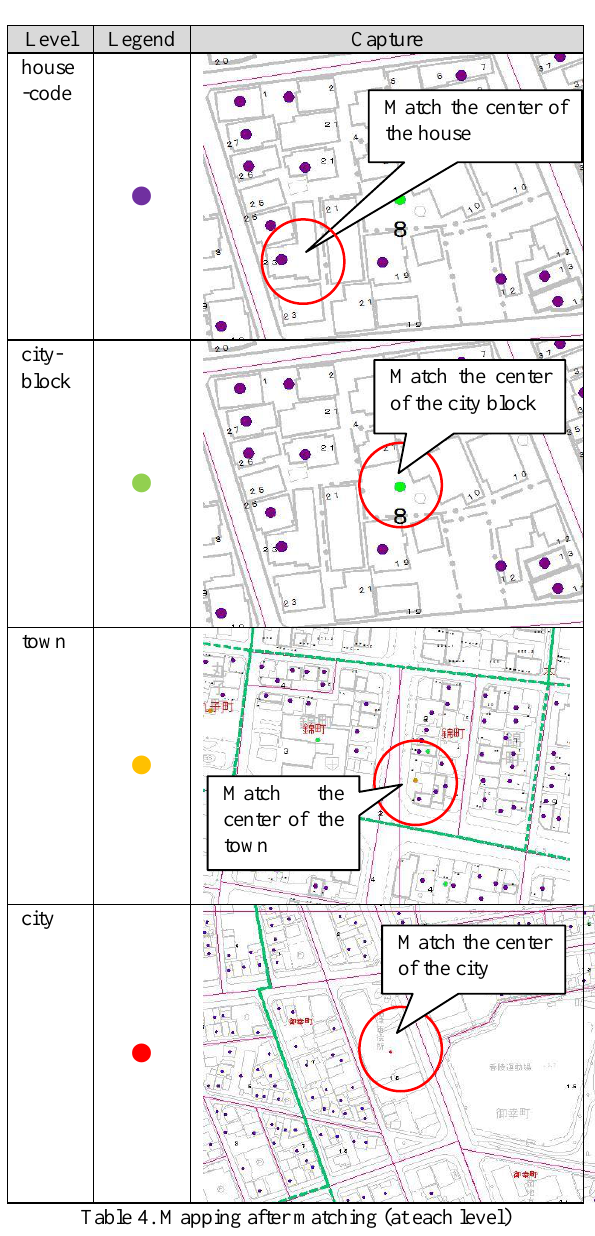
Table 4. Mapping after matching (at each level)